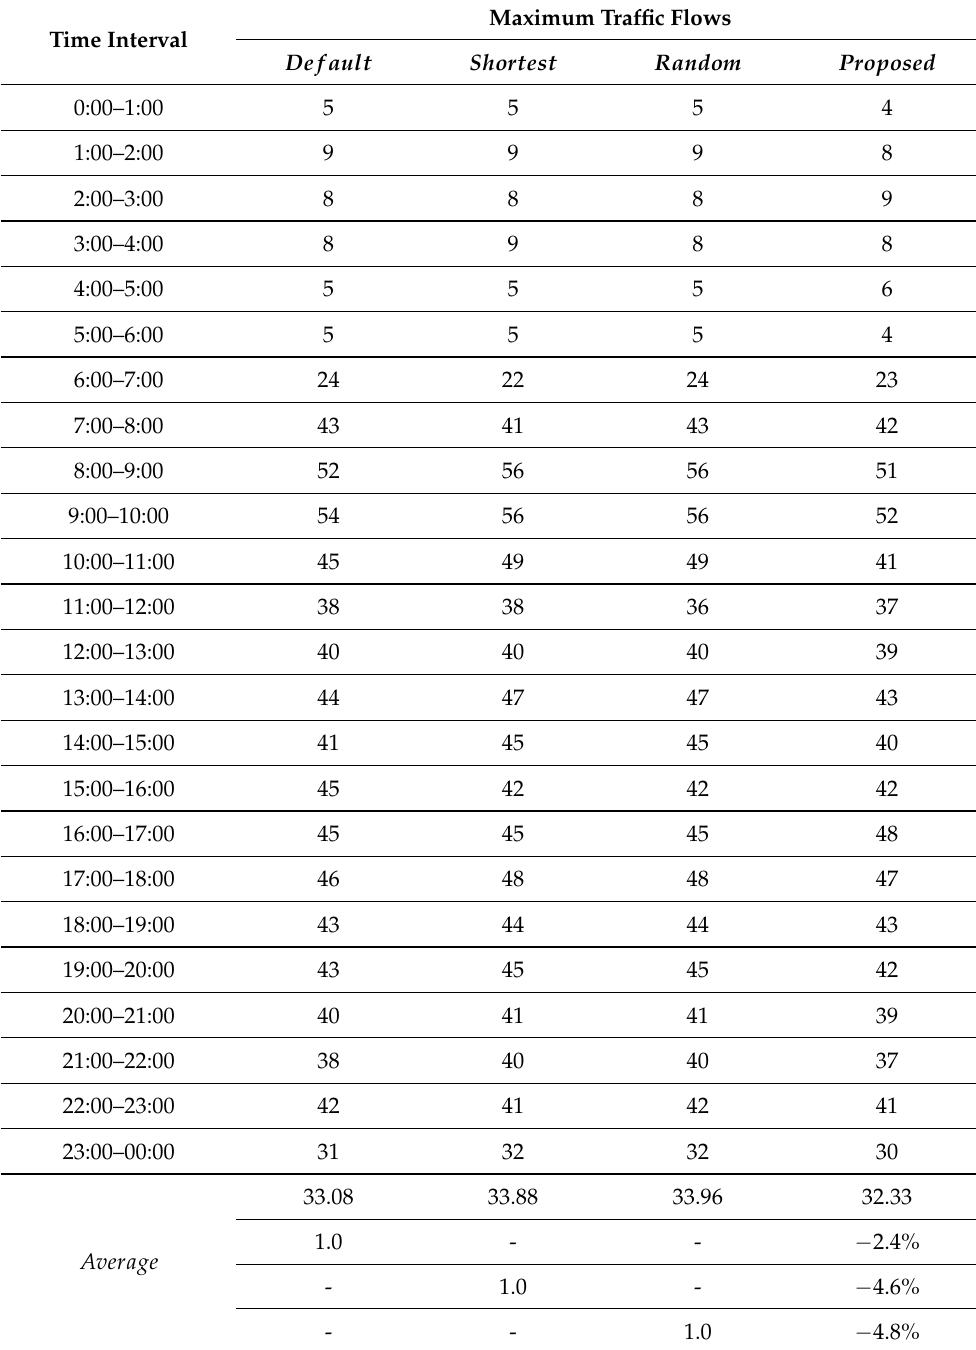
Table 3. The maximum traffic flows of air route segments in different time intervals using different routing path